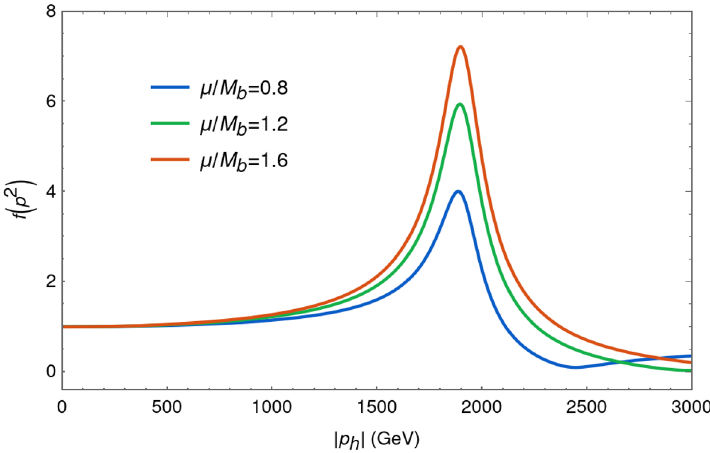
Figure 6 . Higgs-Gauge Boson form factor from scalar exchange, (4.6), normalized by 2 M 2 M b = 1 . 9